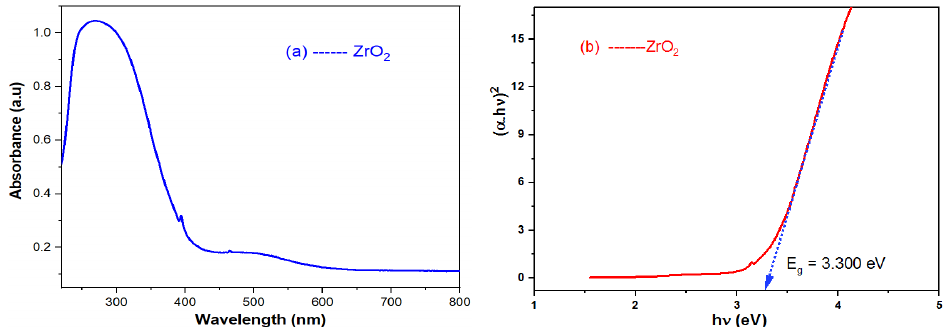
Figure 10. ( a ) The UV-Vis-DRS and ( b ) the Kubelka-Munk energy curve versus the band gap of